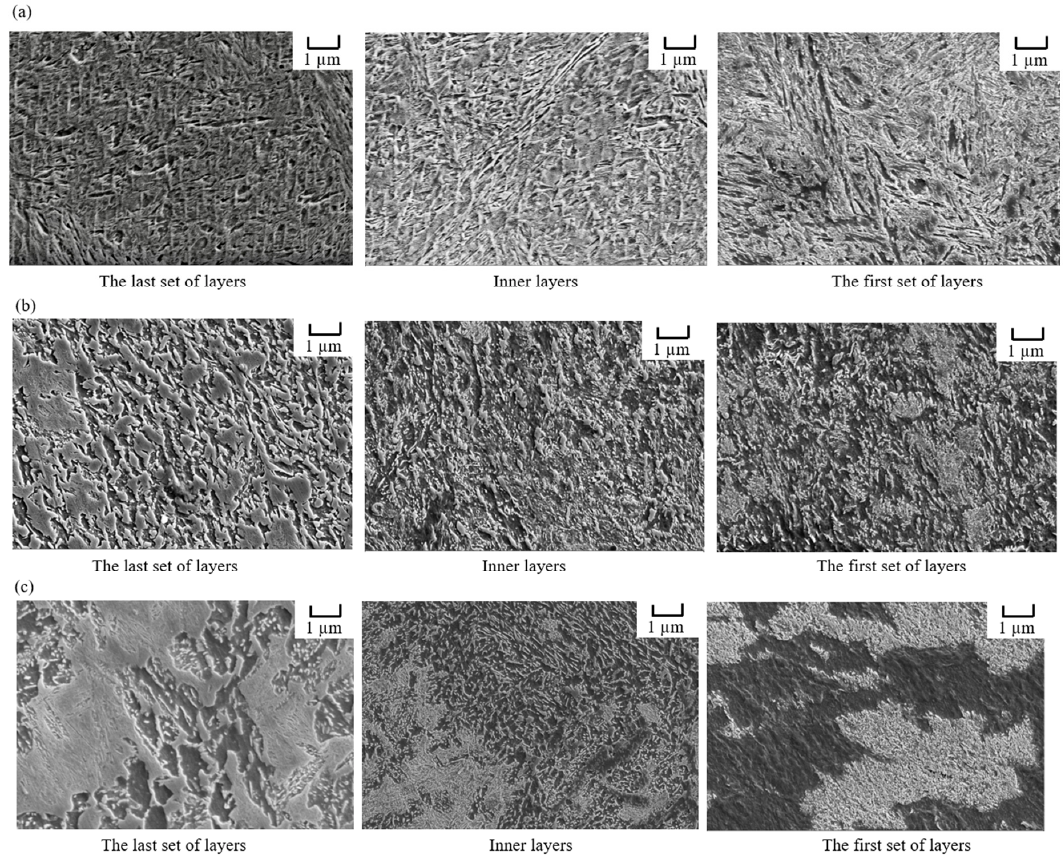
Figure 18. SEM picture of a cross-section of a sample ( a ) built with strategy a, ( b ) built with strategy b and ( c ) built with strategy c, microstructure of the last set of layers, inner layers, and the first set of layers.